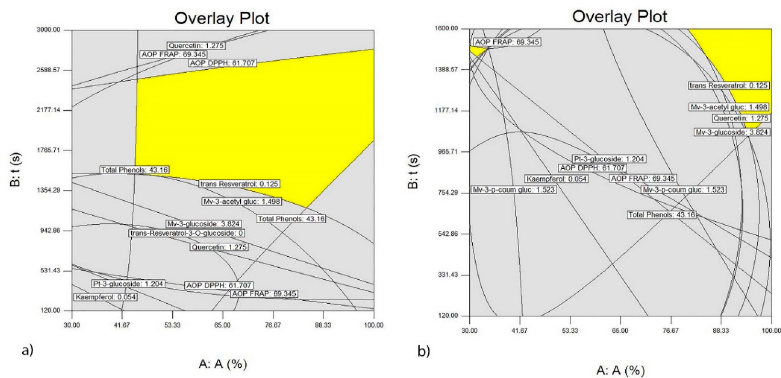
Figure 7. Optimal conditions of the ultrasound-assisted extraction of polyphenolic compounds from the wine lees of the Vranac variety which most significantly affect the AOP of the extracts using the ultrasonic probe with a diameter of 22 mm ( a ) and using the ultrasonic probe with a diameter of 40 mm ( b ). The obtained results regarding AOP are in accordance with other authors [45,73], who also confirmed an increase of AOP in wine lees extracts obtained with non-thermal technologies compared to the CE. The obtained results regarding TPC are also in accordance with other authors [45,73]. They also confirmed an increase of TPC in wine lees extracts obtained with use of non-thermal technologies compared to the CE. Results show that trans -resveratrol glucoside was dominant in the extracts of wine lees from the Merlot while trans -resveratrol content is 20-fold lower. In comparison to the wine lees of the Merlot, trans -resveratrol glucoside (t-Res-3- O -glc) was not found in the wine